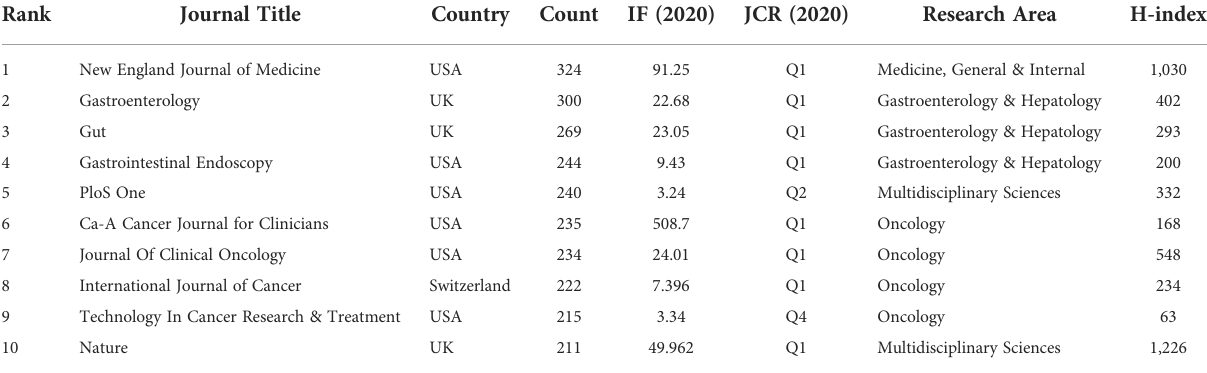
TABLE 1 Top 10 journal published analysis concerning the research of AI on EC (2000 -